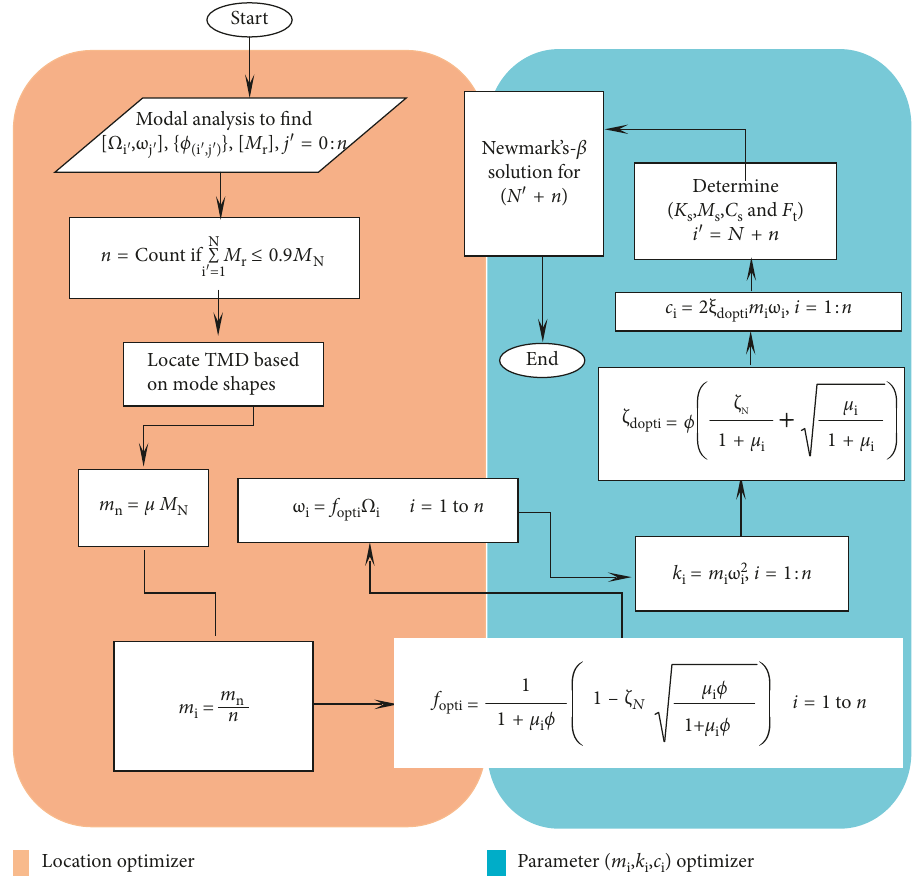
Figure 2: Flowchart for location and design parameters of d-TVAs for seismic response control of